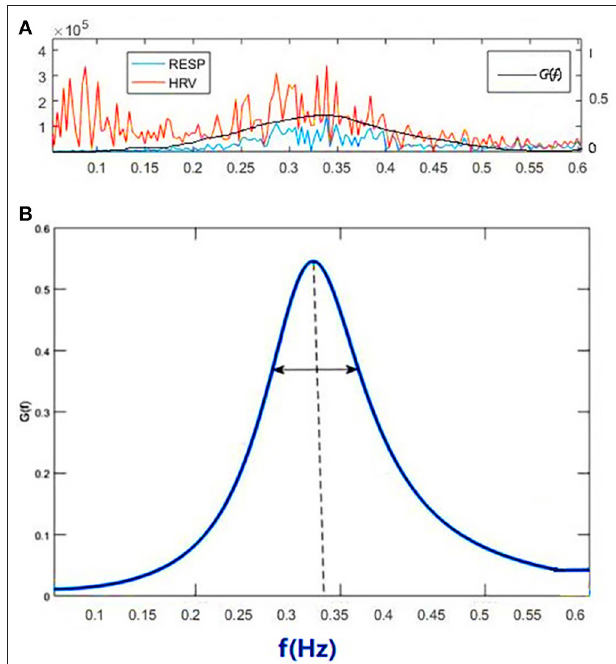
FIGURE 1 | Illustration of Cardiopulmonary Resonance Function (CRF) and Cardiopulmonary Resonance Indices (CRI). (A) the power spectral curves of RR interval series and respiration series, as well as the corresponding cardiopulmonary resonance function, G(f) . (B) the schematic diagram of CRA and CRW. CRA is taken from the maximum point of G(f) (CRF); CRW, the bandwidth of CRF as indicated by the bi-directional arrow line.